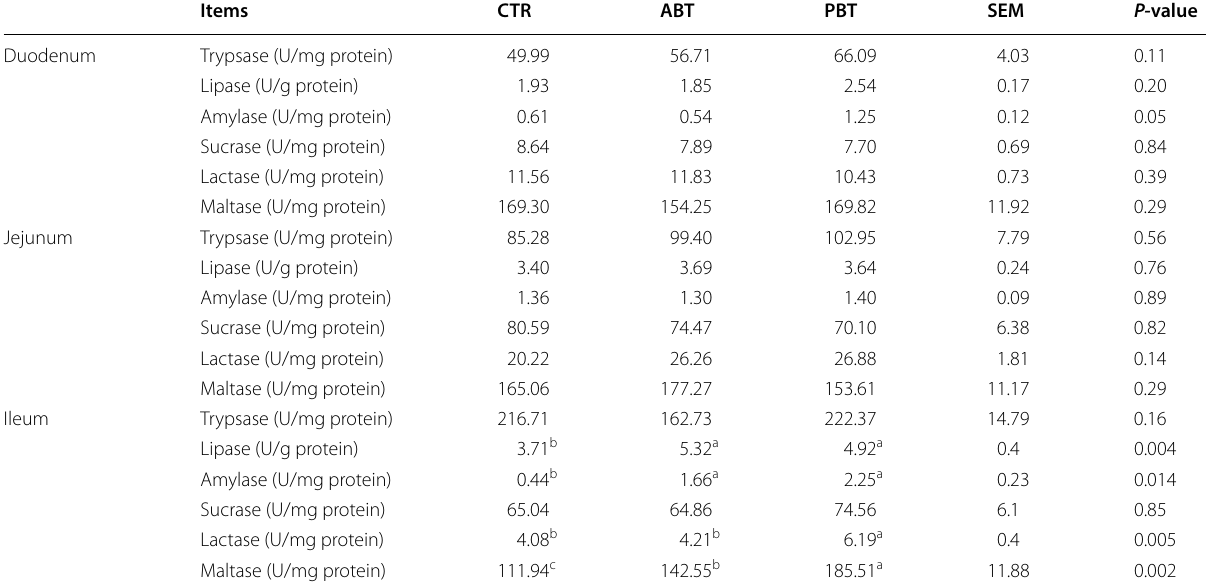
Table 4 Effects of dietary B. subtilis supplementation on mucosal digestive enzyme of piglets